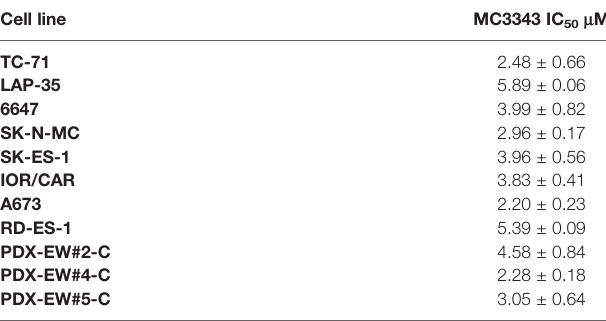
TABLE 1 | Cytotoxic effects of the DNMTi MC3343 in EWS cell lines. Cell